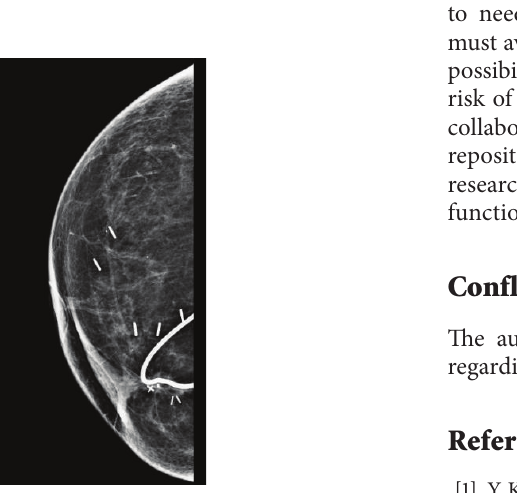
Figure3:2014Mammogram.Stableradiopaquewireoverlyingright breast; interval postlumpectomy changes without